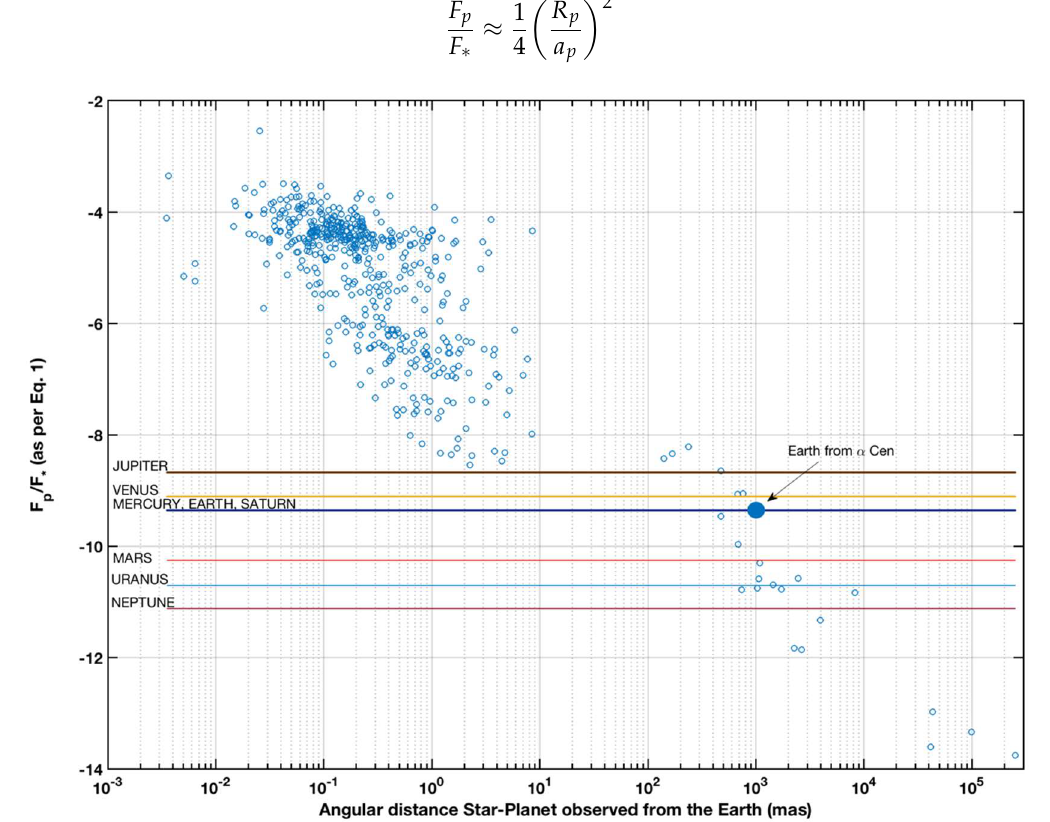
Figure 3. The F p / F * ratios and angular distances of exoplanetary systems as per exoplanet.eu (in July 2018). The F p / F * ratios are also plotted for Solar System planets. The bottom left source is WD 0806- 661 b, one of the coldest known brown dwarfs (T eff = 300–345 K) [2], included in the data base. F p / F * ratios are given in logarithmic